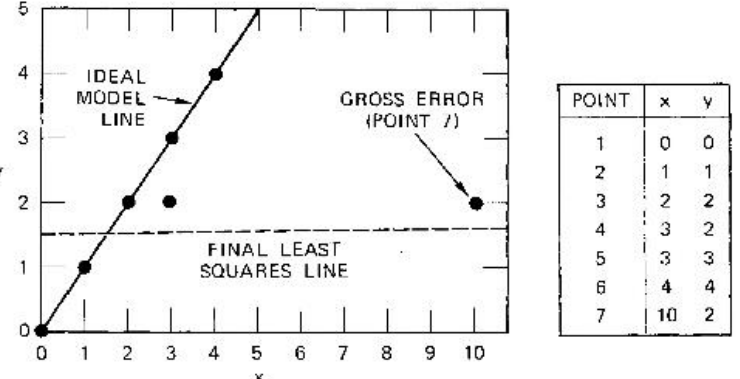
Figure 3. Failure in the reduction to least squares for the estimation of data affected by gross error (after [60]).